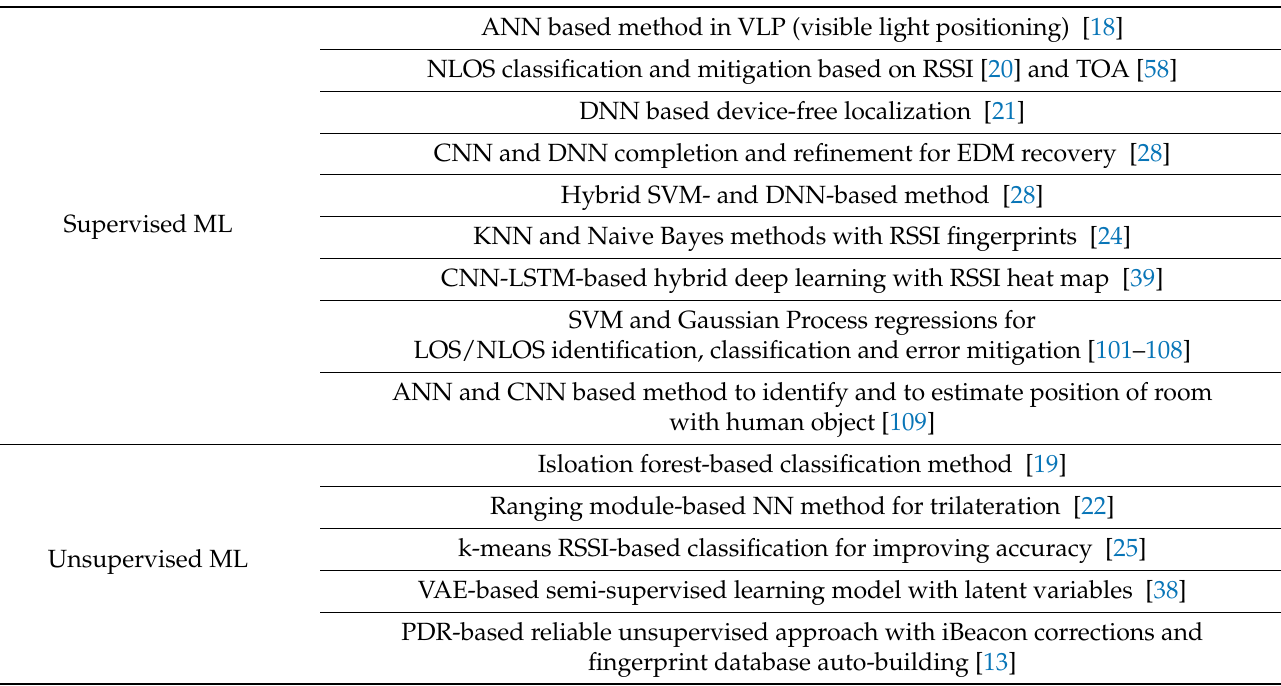
Table 2. Supervised/unsupervised machine learning